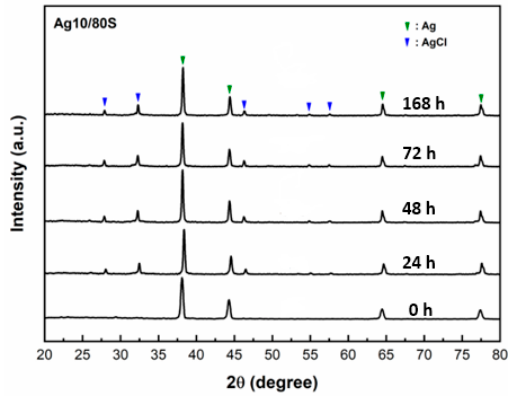
Figure 4. XRD patterns of Ag10/80S after immersion in PBS for different times.